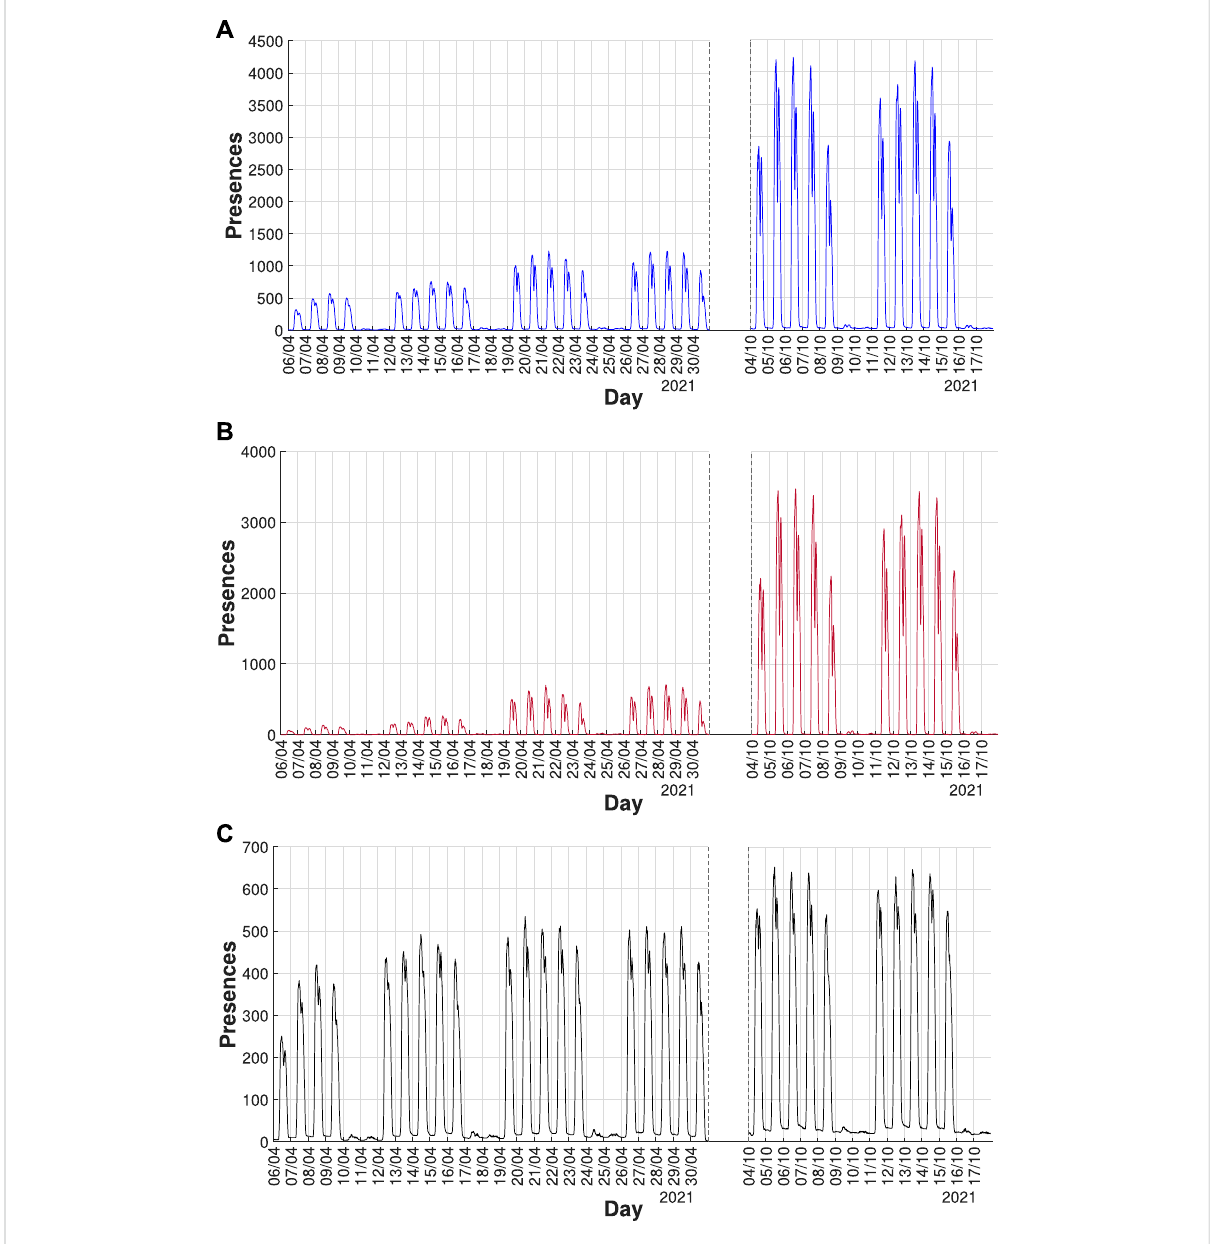
DynamicalbehaviorofattendanceatParma University.Plotoftemporalevolutionoftheattendanceofallusers (A) ,students (B), andstructured staff (C) during the different closing phases. The fi rst 2 weeks correspond to the closing phase, the two central weeks to the partial opening phase, and the last 2 weeks to the total opening phase. We can observe a signi fi cant increase in attendance for students in different phases, while for structured staff, we fi nd a very similar dynamical behavior of attendance between different regimes. The data are very detailed and give much information, such as the low number of attendances during the weekend and during